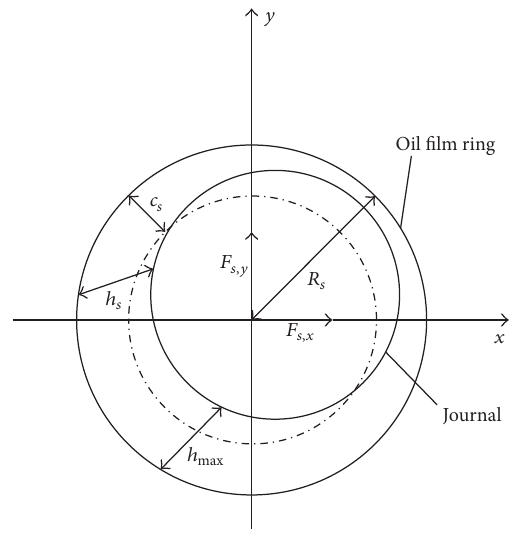
Figure 1: Model of the